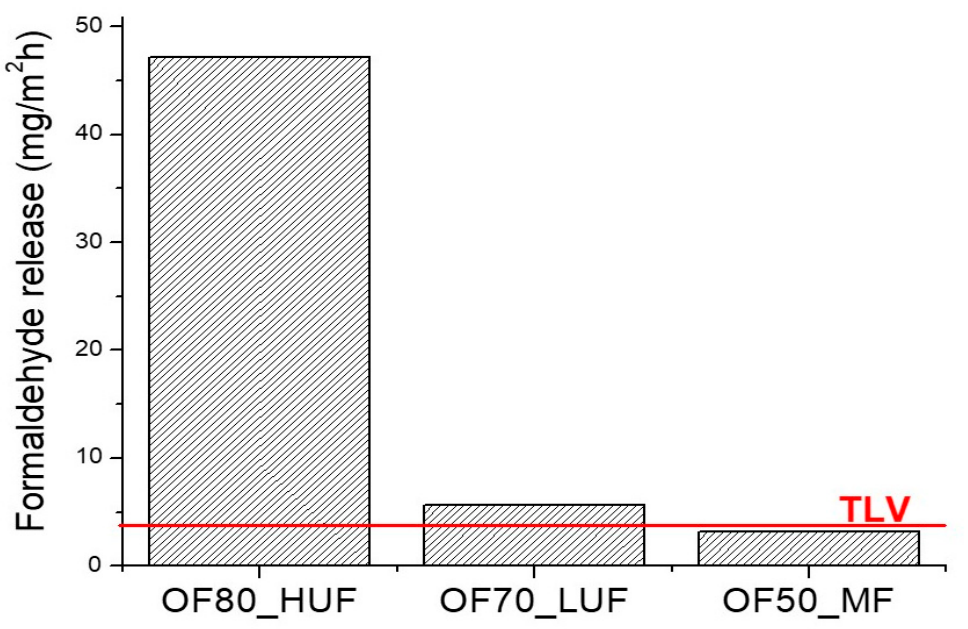
Figure 6. Formaldehyde release according to UNI EN 717-2 standard.